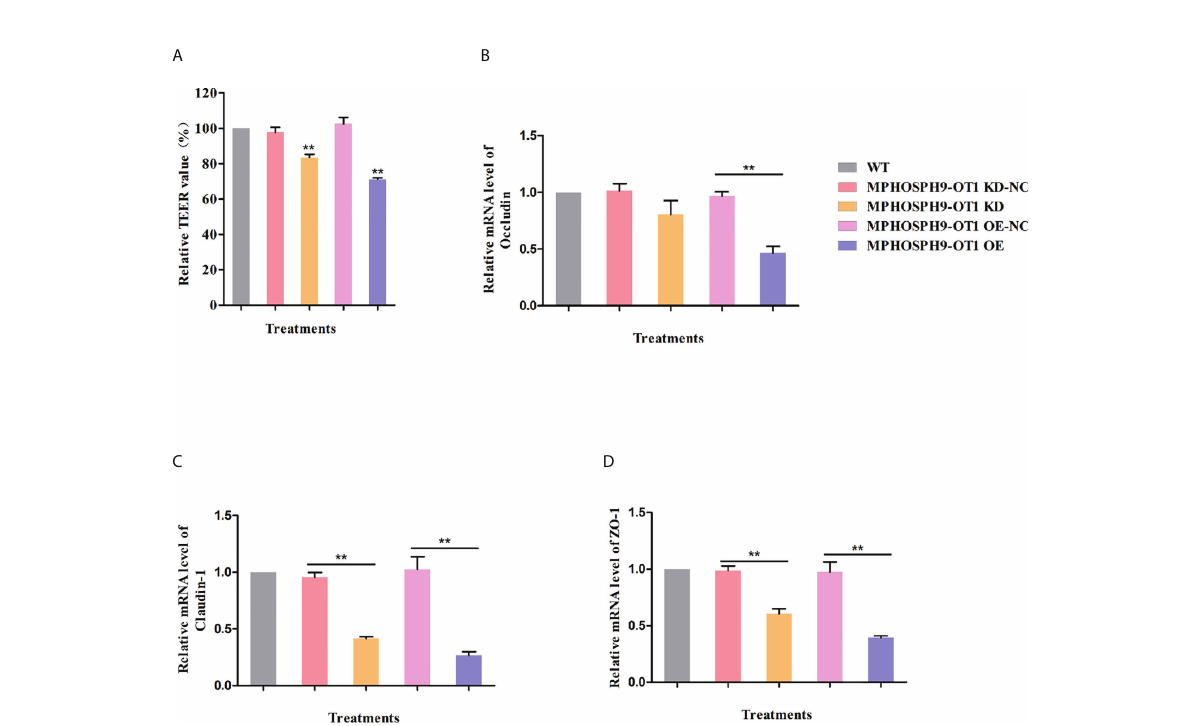
FIGURE 6 MPHOSPH9-OT1 knockdown or overexpression negatively affects the barrier function of IEPC-J2 cells. (A) The KD and OE of MPHOSPH9-OT1 down-regulated TEER values of monolayer IPEC-J2 cells. **P < 0.01 compared to WT. (B – D) The KD and OE of MPHOSPH9-OT1 decreased the transcript level of Occludine (B) , Claudin-1 (C) , and ZO-1 (D) . The expression analysis was performed using qRT-PCR and calculated by the 2 - DD Ct method normalized to GAPDH. The relative expression levels of all treatments were shown with the expression fold number compared to WT. **P < 0.01